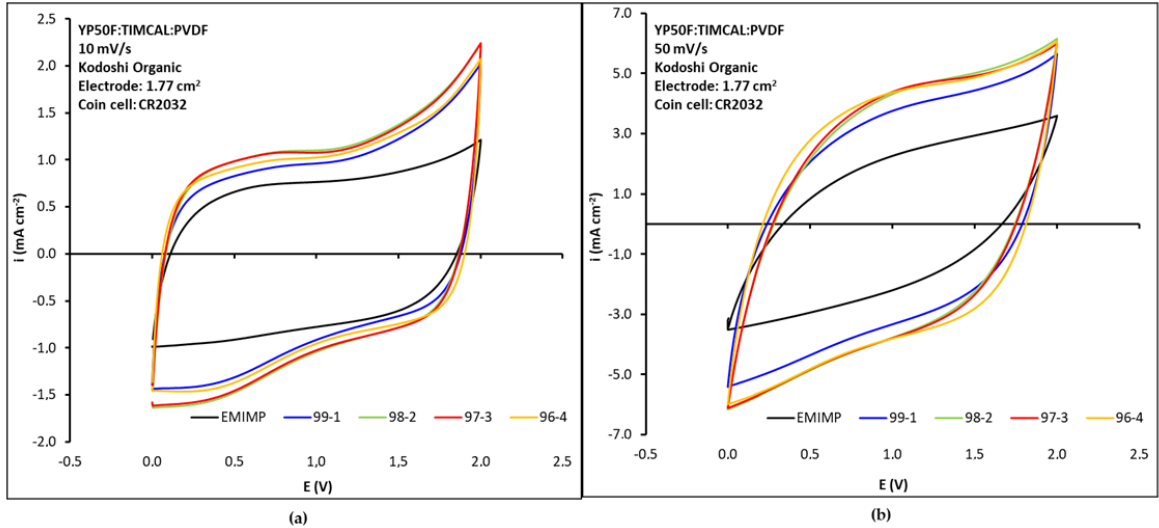
Figure 5. CV (cyclic voltammetry) curves at ( a ) 10 mV s − 1 ; ( b ) 50 mV s − 1 scan rates for each EM- IMP/CNFc ionogel (99:1, 98:2, 97:3 and 96:4). Pristine EMIMP is also added for comparison.